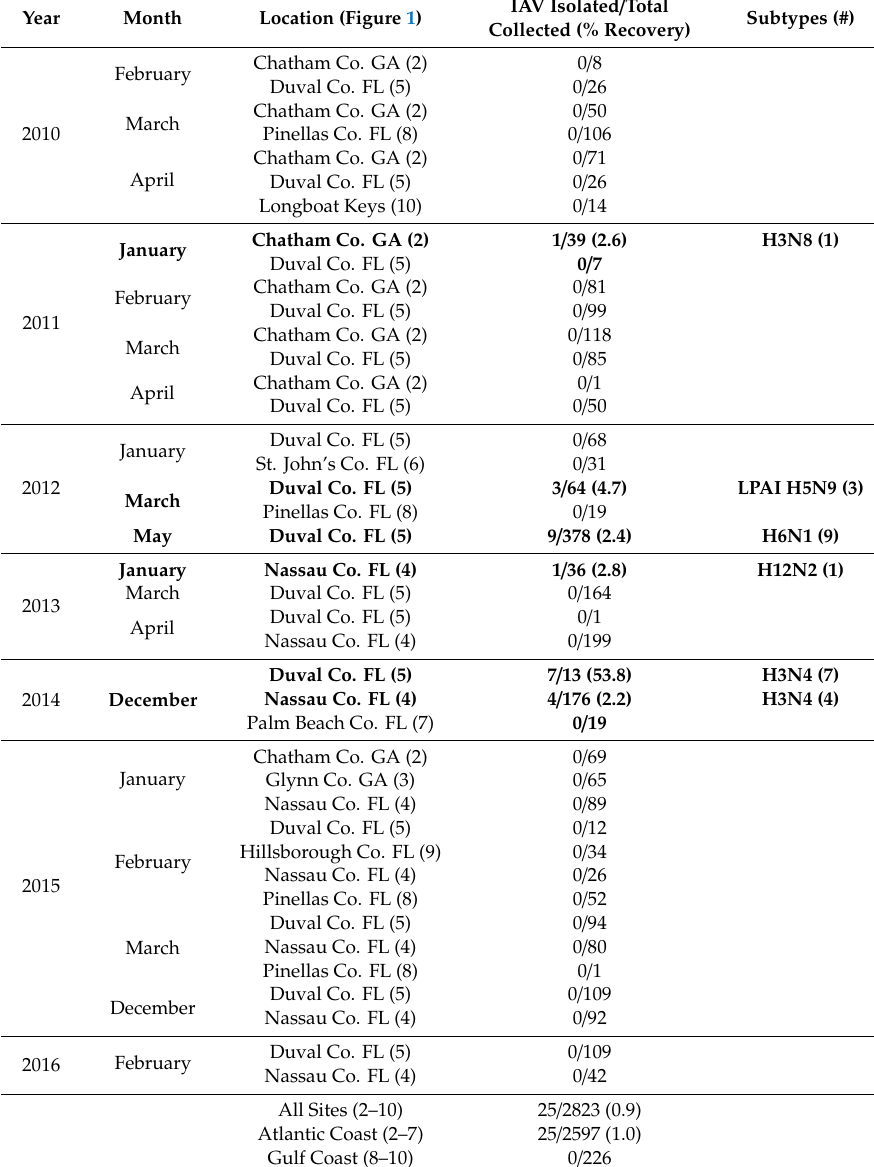
Table 1. Estimated influenza A virus (IAV) prevalence and subtype recovery from shorebird fecal samples collected at southeastern United States sites on the Atlantic or Gulf of Mexico Coasts, prior to shorebird migration through Delaware Bay, from 2010–2016. Bold entries indicate collection months and locations from which IAV were isolated from